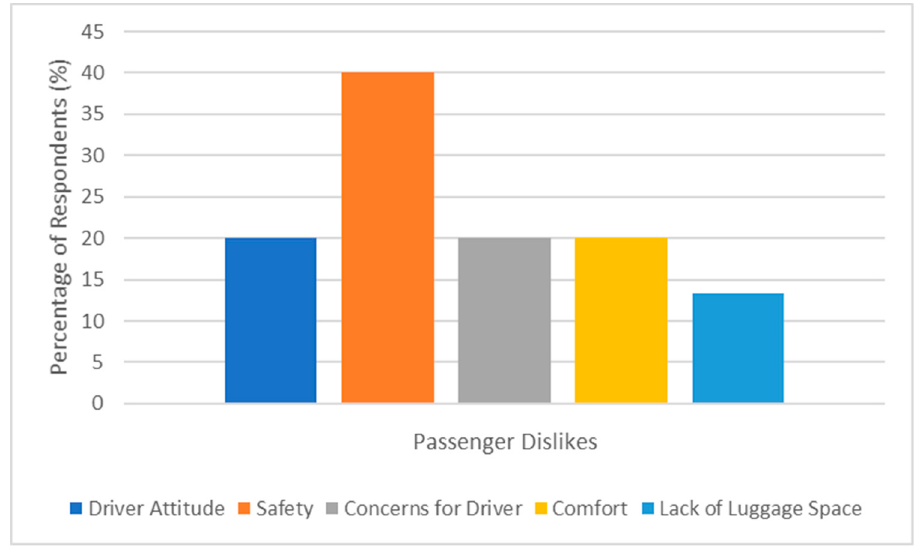
Figure 3. Passenger dislikes.